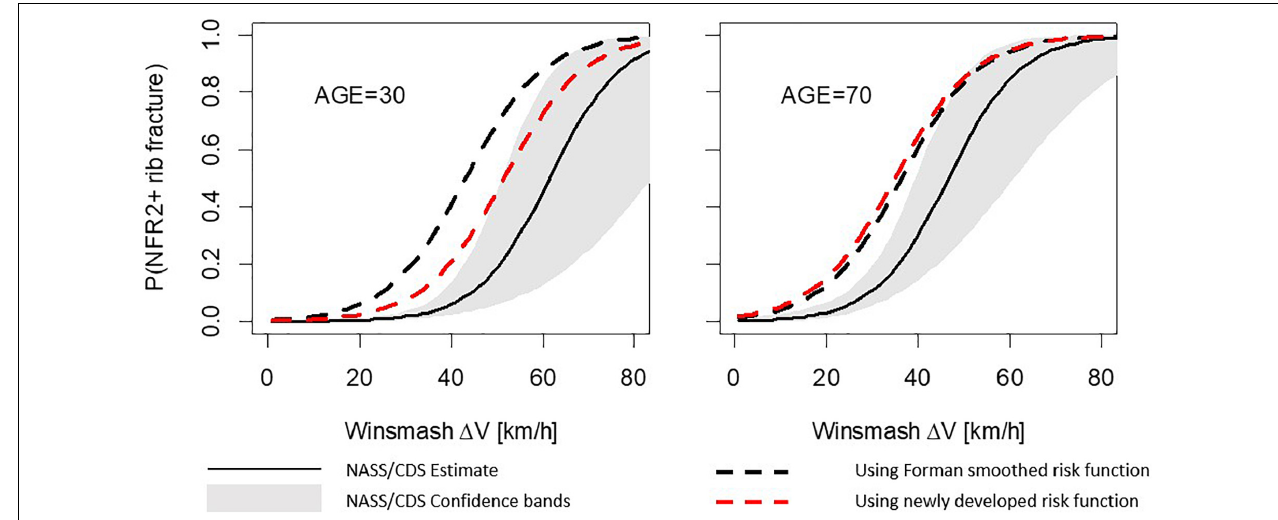
FIGURE 5 | Number of fractured ribs, NFR2 + ; predictions for the lateral stochastic simulations. Comparison between risk curves from probabilistic framework using Forman smoothed and the newly developed risk functions for a 30-year-old occupant (left) and 70-year-old occupant (right) .